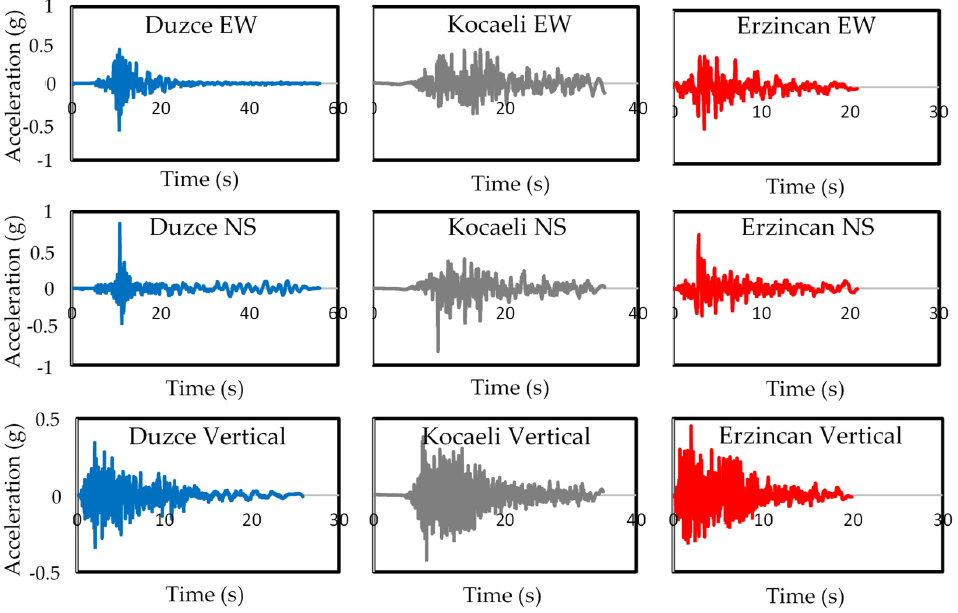
Figure 8. Site-specific ground motions used in the numerical analysis. The horizontal and vertical design spectra for the bridge site obtained at a 5% damping ratio are shown in Figure 9a, b, along with the average spectra for the matched ground motion time histories. The earthquake load reduction coefficient was assumed as R = 3.0 according to [4].